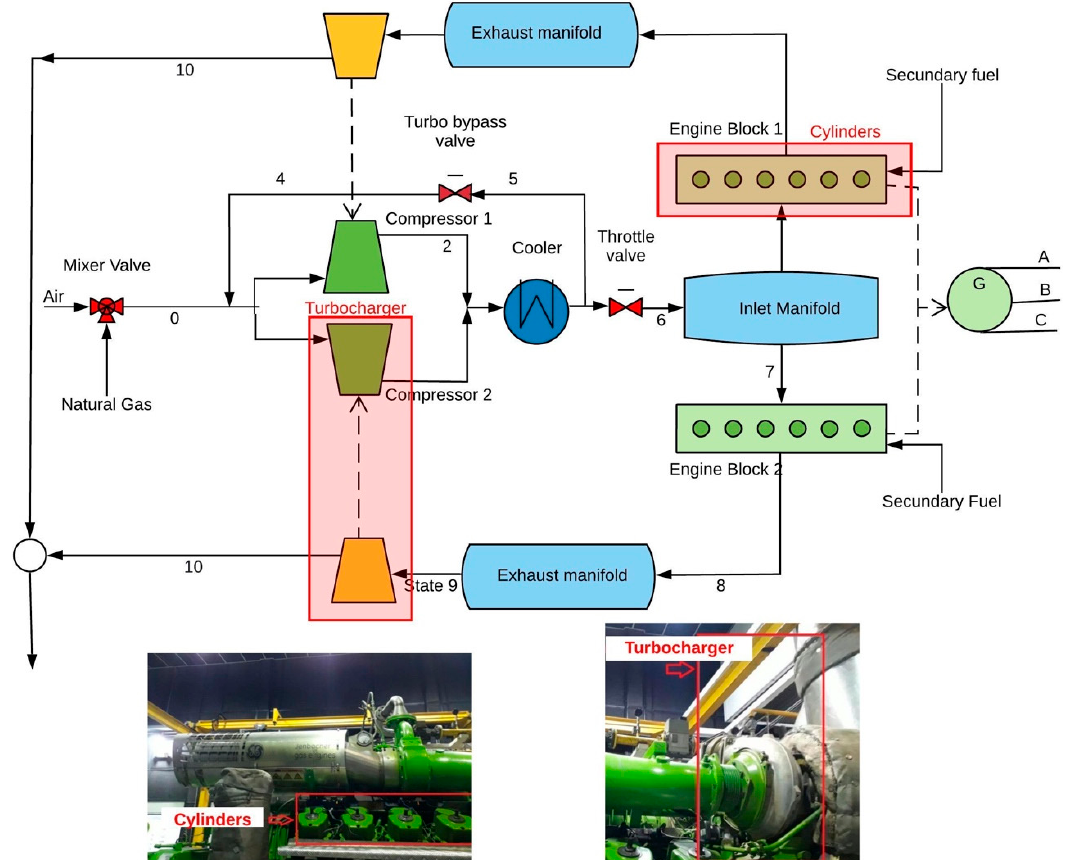
Figure 1. Physical structure of the Jenbacher JMS 612 GS-N. L.